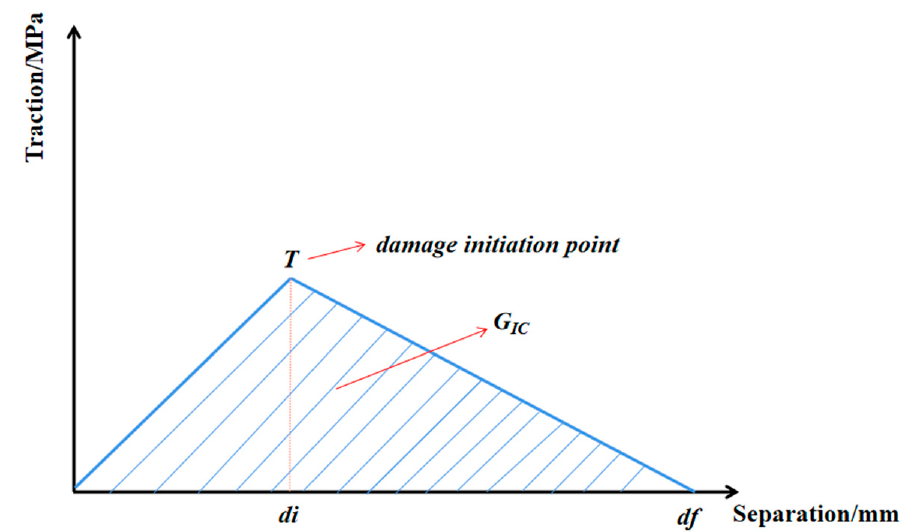
Figure 6. Cohesion model used in this paper.